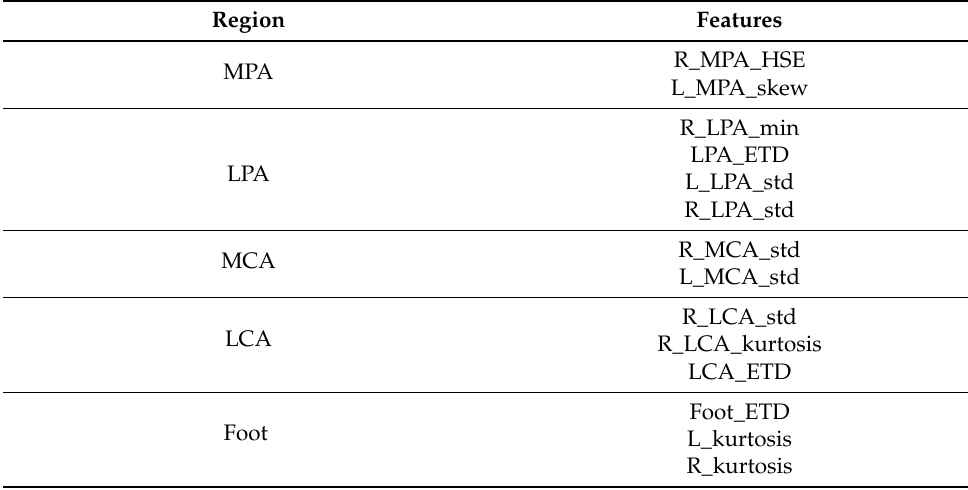
Table A1. Most relevant features extracted for all the approaches considered and listed according to angiosome. The search for coincidence was restricted to the first 30 ranked features provided for each approach. Features found up to a rank lower than 50 were